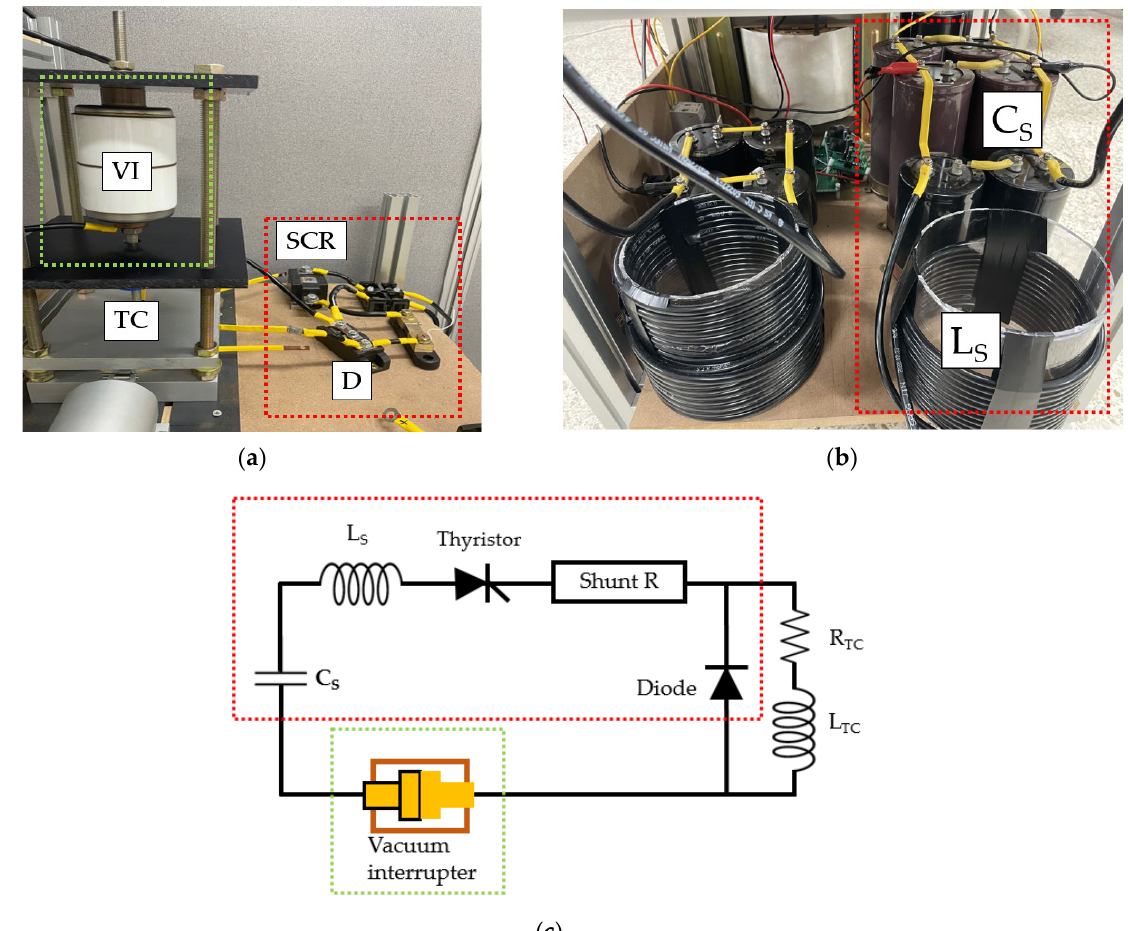
Figure 9. Thomson coil actuator: ( a ) TC setup; ( b ) TC operation capacitor C S and inductor L S ; ( c ) circuit diagram of TC setup. Red dotted box: matches elements in the actual configuration picture and circuit diagram.